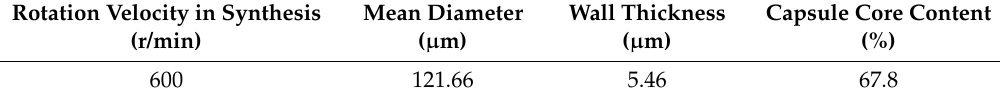
Table 1. Microcapsules parameters.